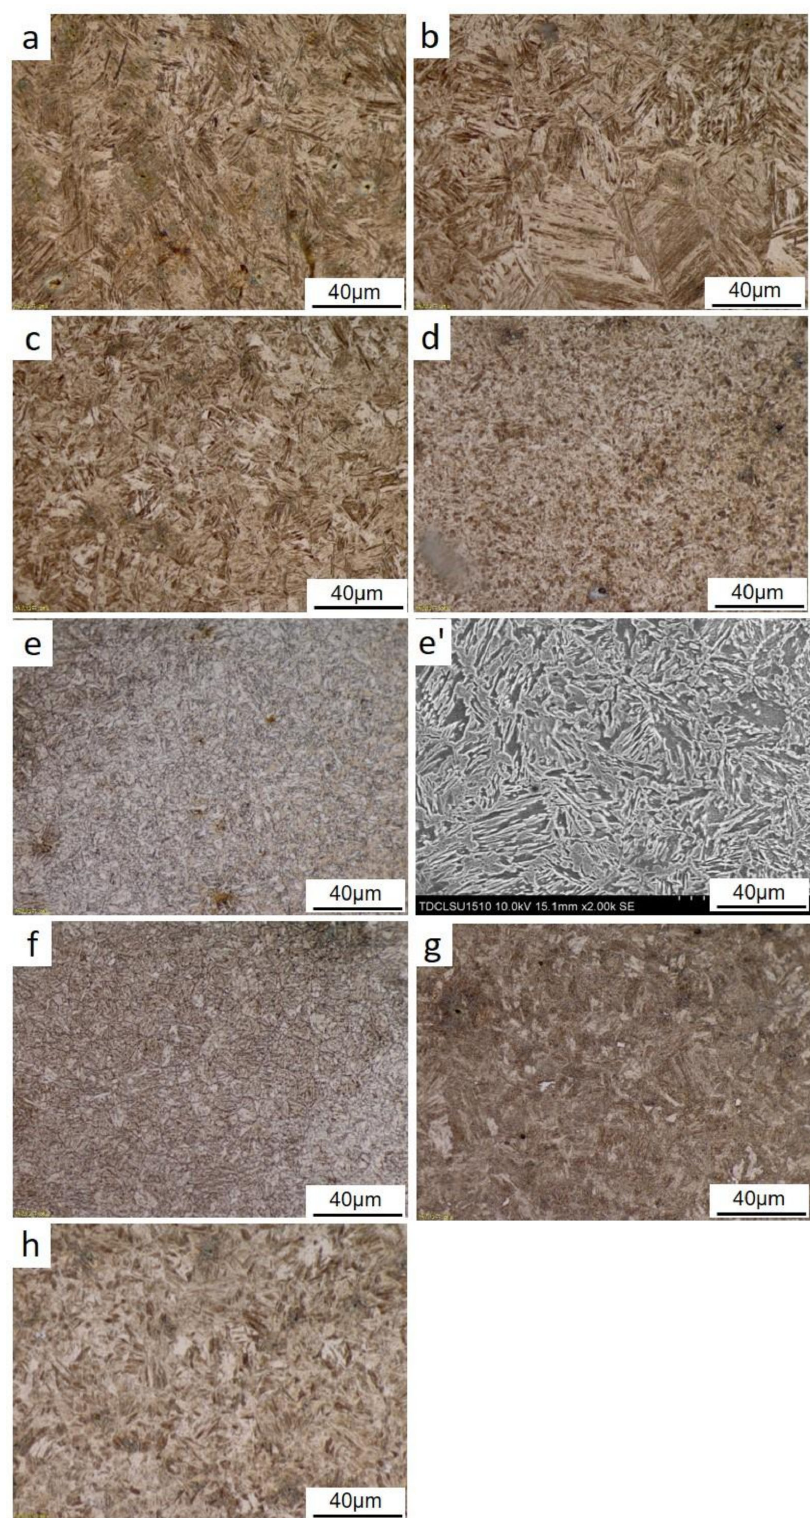
Figure 6. Microstructures of different micro regions in a spot welding joint, corresponding to ( a )~( e ) marked in Figure 5: ( a ) nugget, composed of fine martensite within columnar grains; ( b ) fusion zone, mix of coarse martensite and fine martensite; ( c ) martensite; ( d ) minute martensite; ( e ) acicular ferrite under an optical microscope; ( e’ ) acicular ferrite under SEM; ( f ) granular bainite with polygonal matrix; ( g ) granular bainite with a lath-shaped matrix; ( h ) tempered